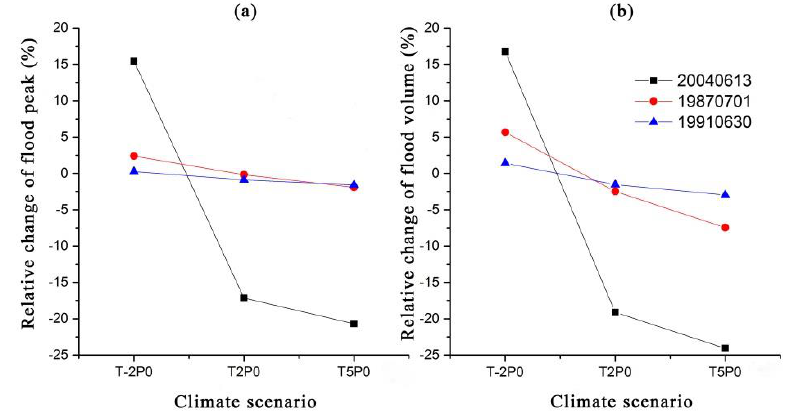
Figure 1. The hydrological response of temperatures changes for different-scaled floods: ( a ) Relative change of flood peak under temperature changes; ( b ) Relative change of flood volume under temperature changes.